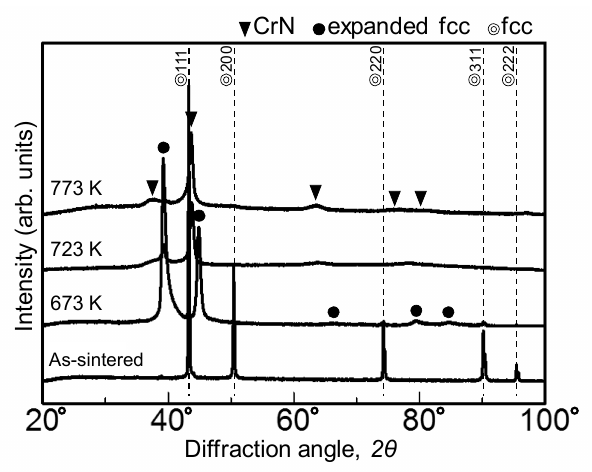
Figure 10. XRD patterns of plasma-nitrided CoCrFeMnNi samples.